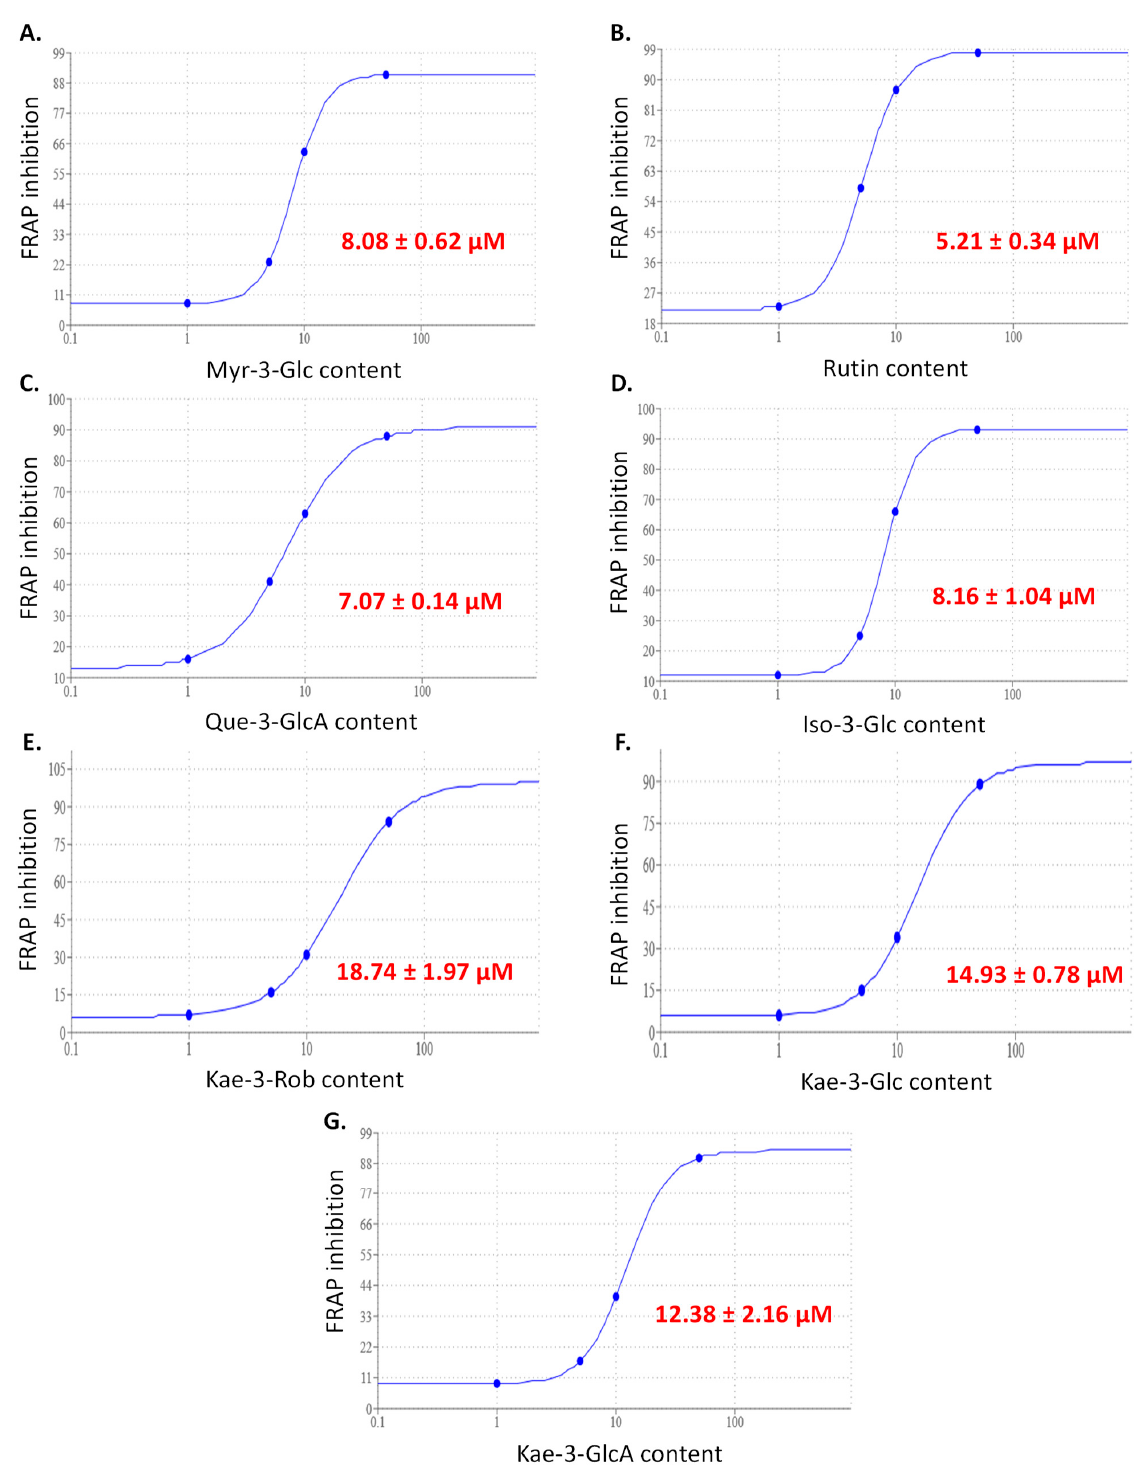
Figure 6. EC50 curves for the FRAP antioxidant activity of Myr-3-Glc ( A ), Rut ( B ), Que-3-Glu ( C ), Iso-3-Glc ( D ), Kae-3-Rob ( E ), Kae-3-Glc ( F ), and Kae-3-Rob ( G ). Myr-3-O-Glc: myricetin-3-O- glucose; Quer-3-O-Rut: quercetin-3-O-rutinoside (rutin); Quer-3-O-GlcA: quercetin-3-O-glucuronic acid; Kae-3-O-Rob: kaempferol-3-O-robinobiose; Kae-3-O-Glc: kaempferol-3-O-glucose; Kae 3-O- GlcA: kaempferol 3-O-glucuronic acid; Iso-3-O-Glc: isorhamnetin-3-O-glucose; Glc: glucose; GlcA: glucuronic acid; Rob: